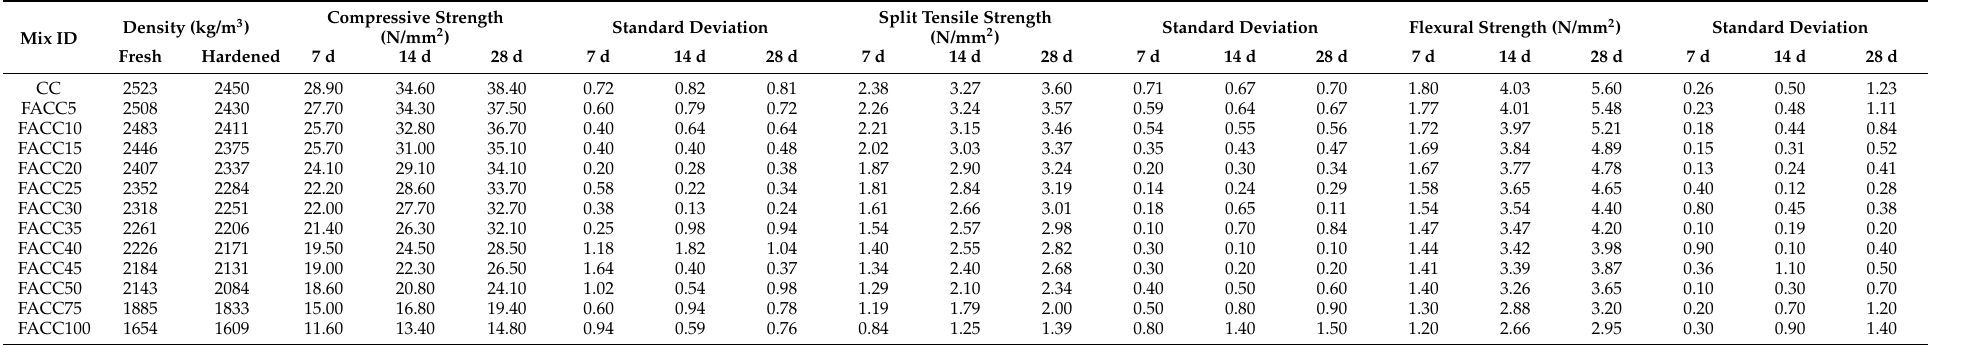
Table 4. Fresh and Hardened Concrete Values of CC and FACC